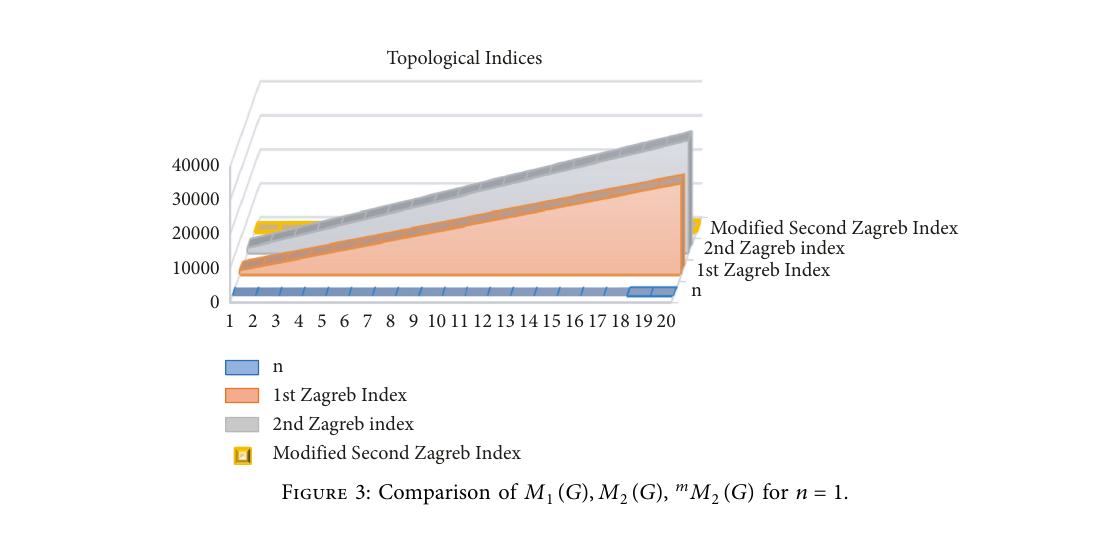
( H ) for n � 1, (b) M 1